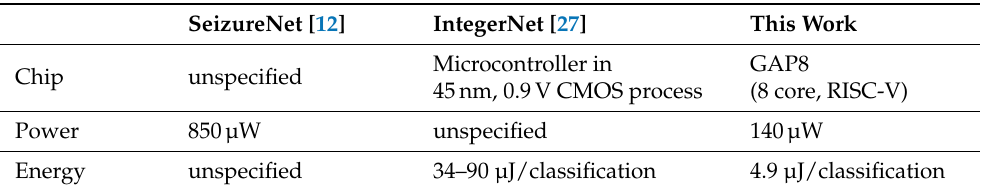
Table 2. Comparison of the energy consumption of a classification task for different chips and classifiers while running a seizure classification.